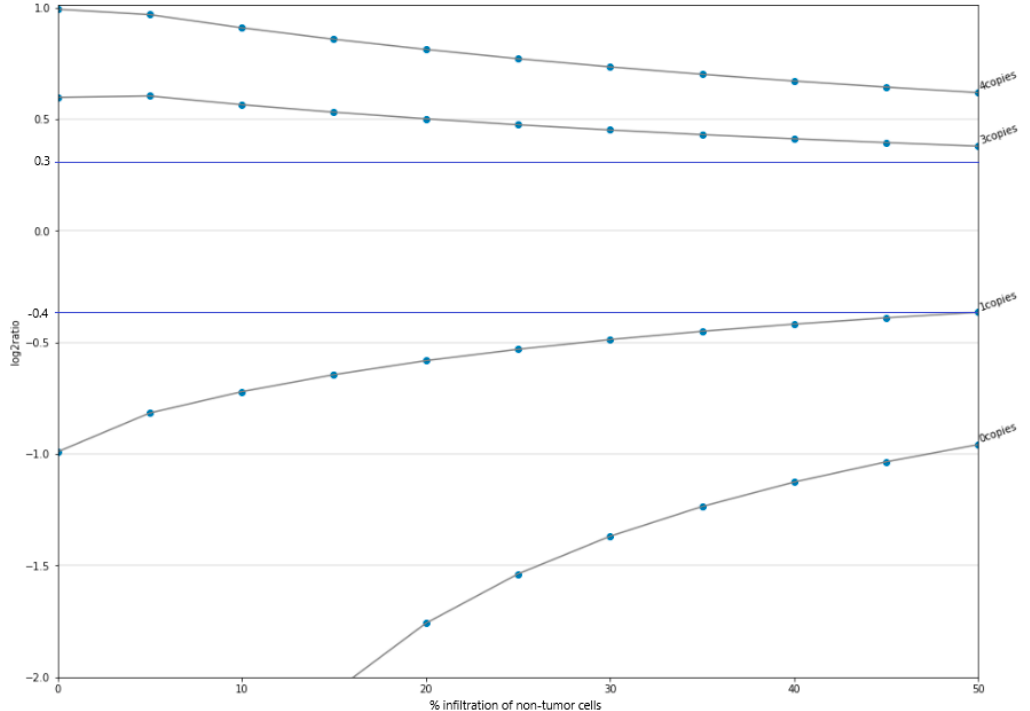
Figure 1. Log 2 ratio variation of the CNV event according to the number of copies versus percentage of infiltration of non-tumor cells in the tumor sample. Beyond 0.3 (top blue line) for insertions (i.e., number of copies > 2) and below − 0.4 (bottom blue line) for deletions (i.e., number of copies < 2) CNVs are